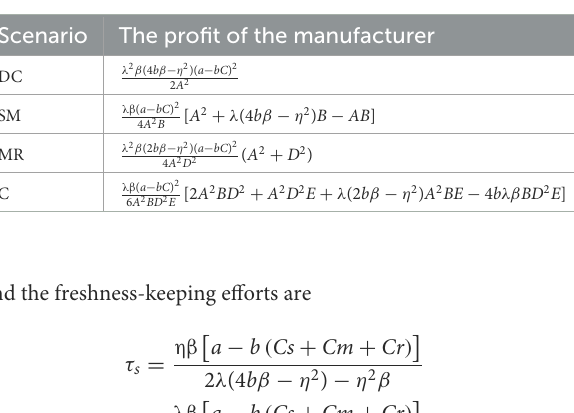
TABLE 4 Profits for the manufacturer under different decision-making